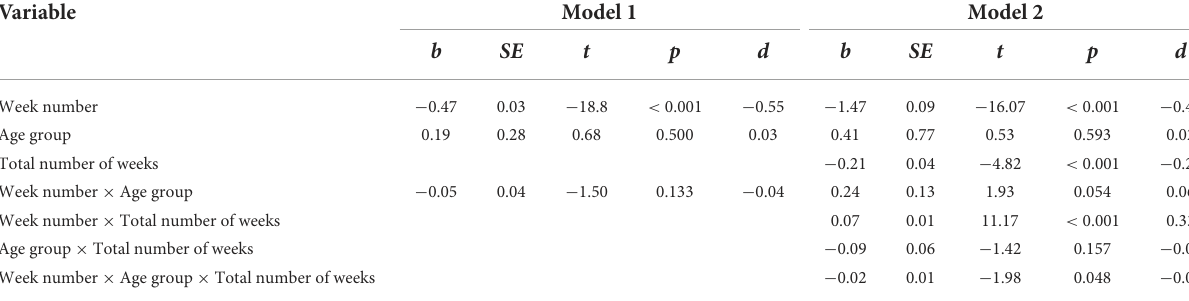
TABLE 5 Fixed main and interaction effects of age group and total number of weeks on rates of change in depressive symptoms.